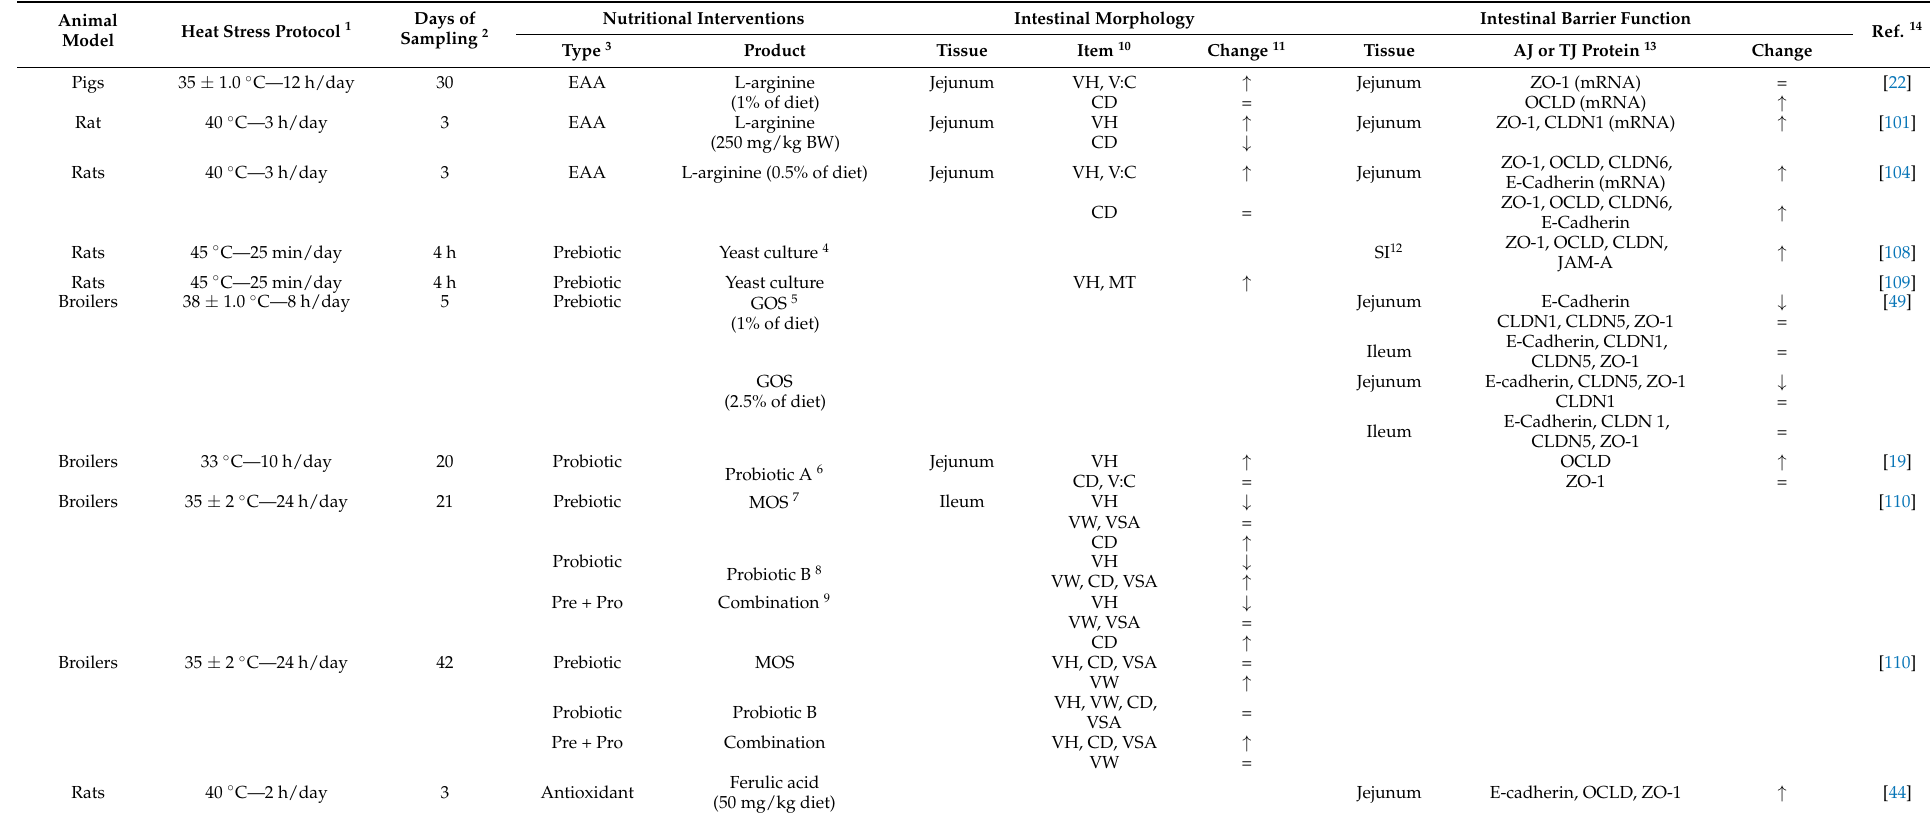
Table 3. Effect of nutritional interventions on the structural and functional changes to small intestine during heat